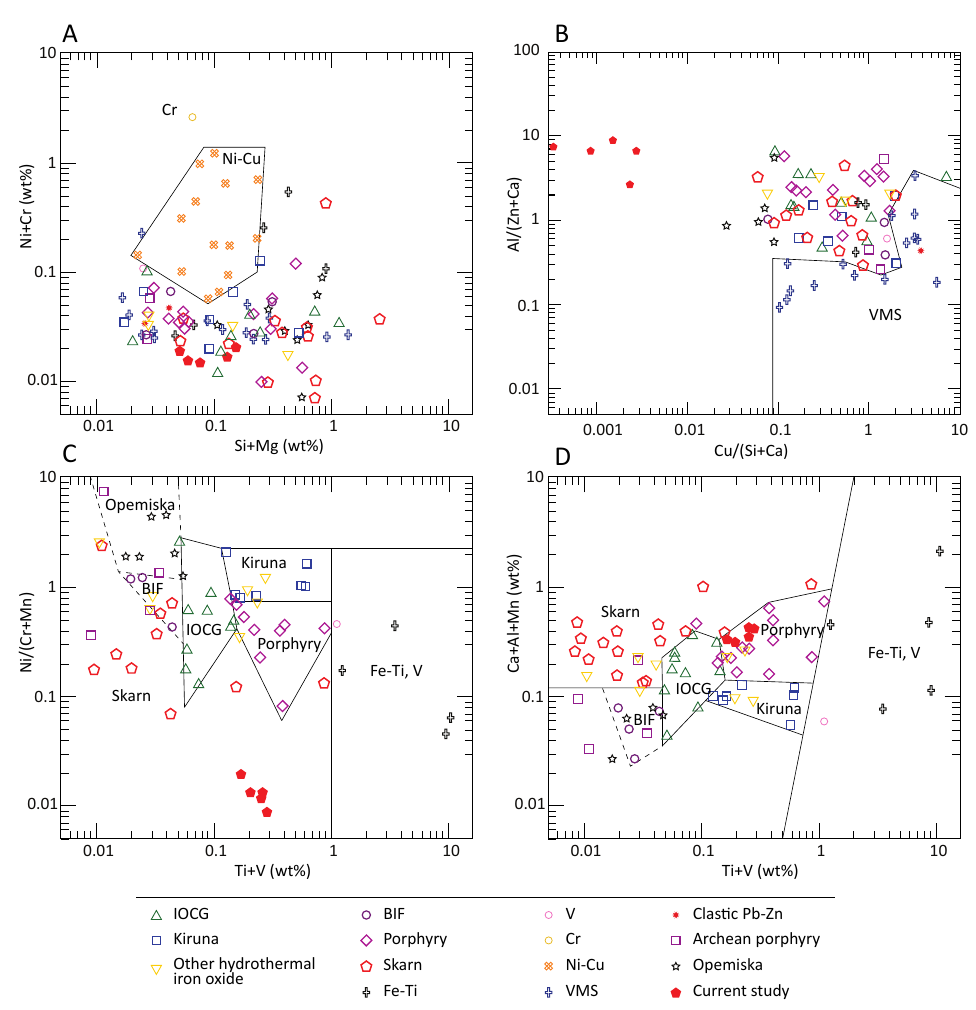
Fig. 8. Magnetite chemical composition on discriminant diagrams: Si + Mg vs Ni + Cr ( A ), Cu/(Si + Ca) vs Al/(Zn + Ca) ( B ), Ti + V vs Ni/(Cr + Mn) ( C ) and Ti + V vs Ca + Al + Mn ( D ). Average compositions of the analyses of the five Jõhvi magnetite grains are plotted together with the initial discriminant data by Dupuis & Beaudoin (2011). The results are compared with magnetite trace element composition data from deposit types of iron oxide copper gold (IOCG), Kiruna, hydrothermal iron oxide, banded iron formation (BIF), porphyry, skarn, iron­titanium, vanadium, chromium, nickel­copper, volcanic massive sulphide (VMS), clastic lead­ zinc, Archean porphyry and